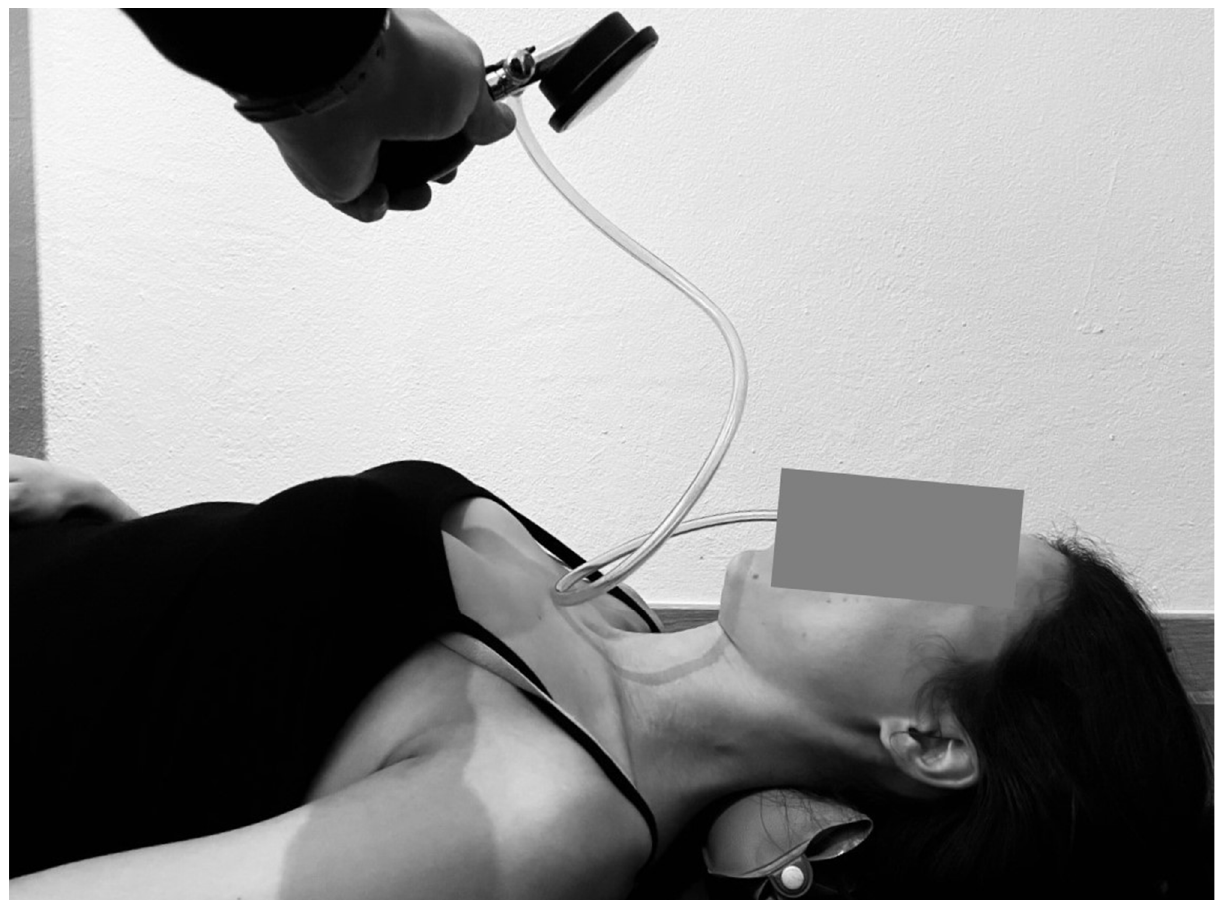
Figure 4. Cranio-cervical flexion test (CCFT) with visual feedback